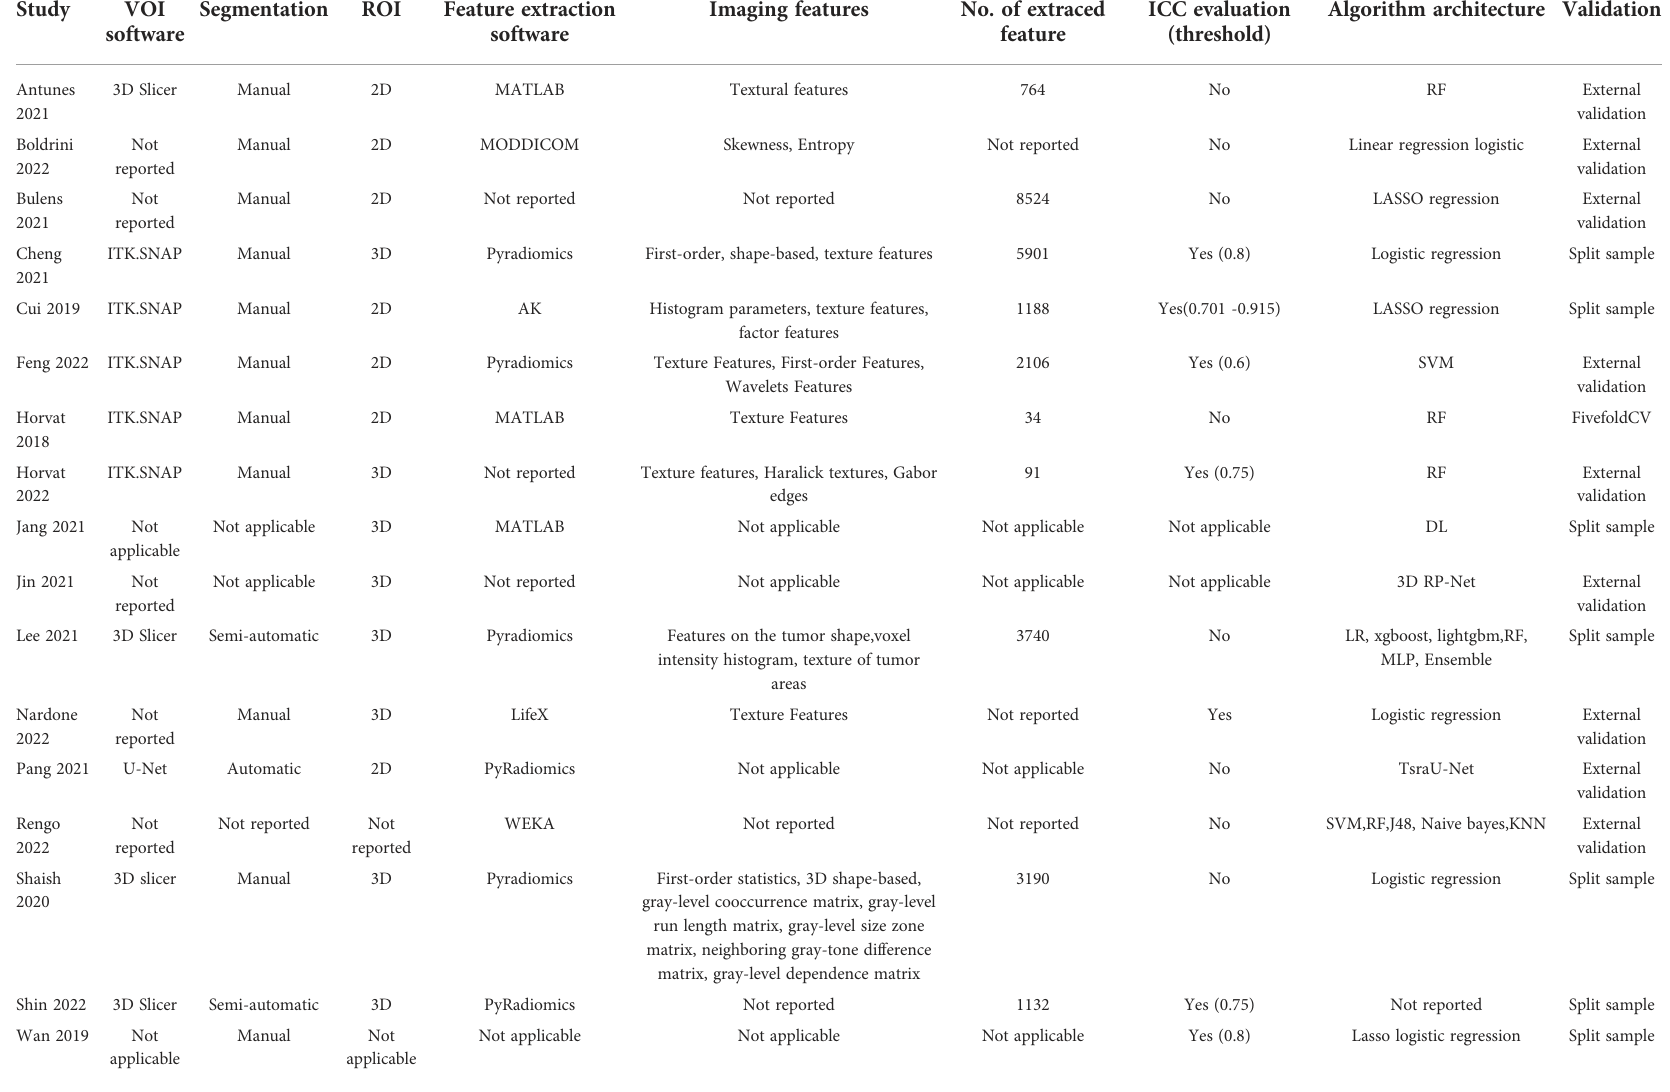
TABLE 2 Summary of arti fi cial intelligence-based prediction model characteristics described in included